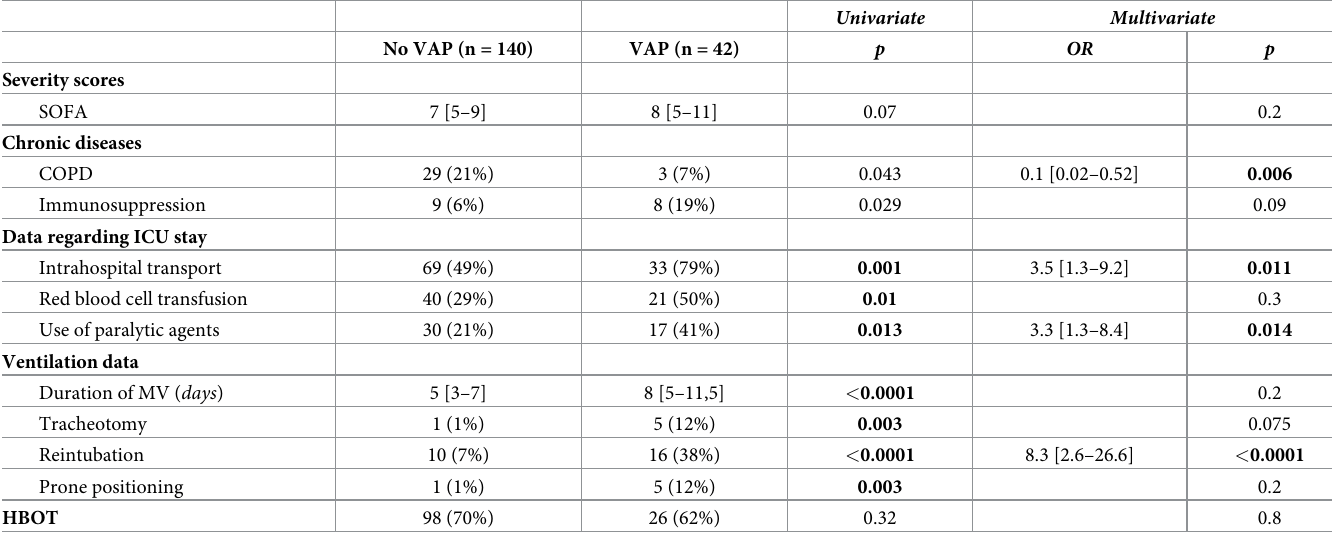
Table 3. Multivariate analysis of risk factors of VAP.